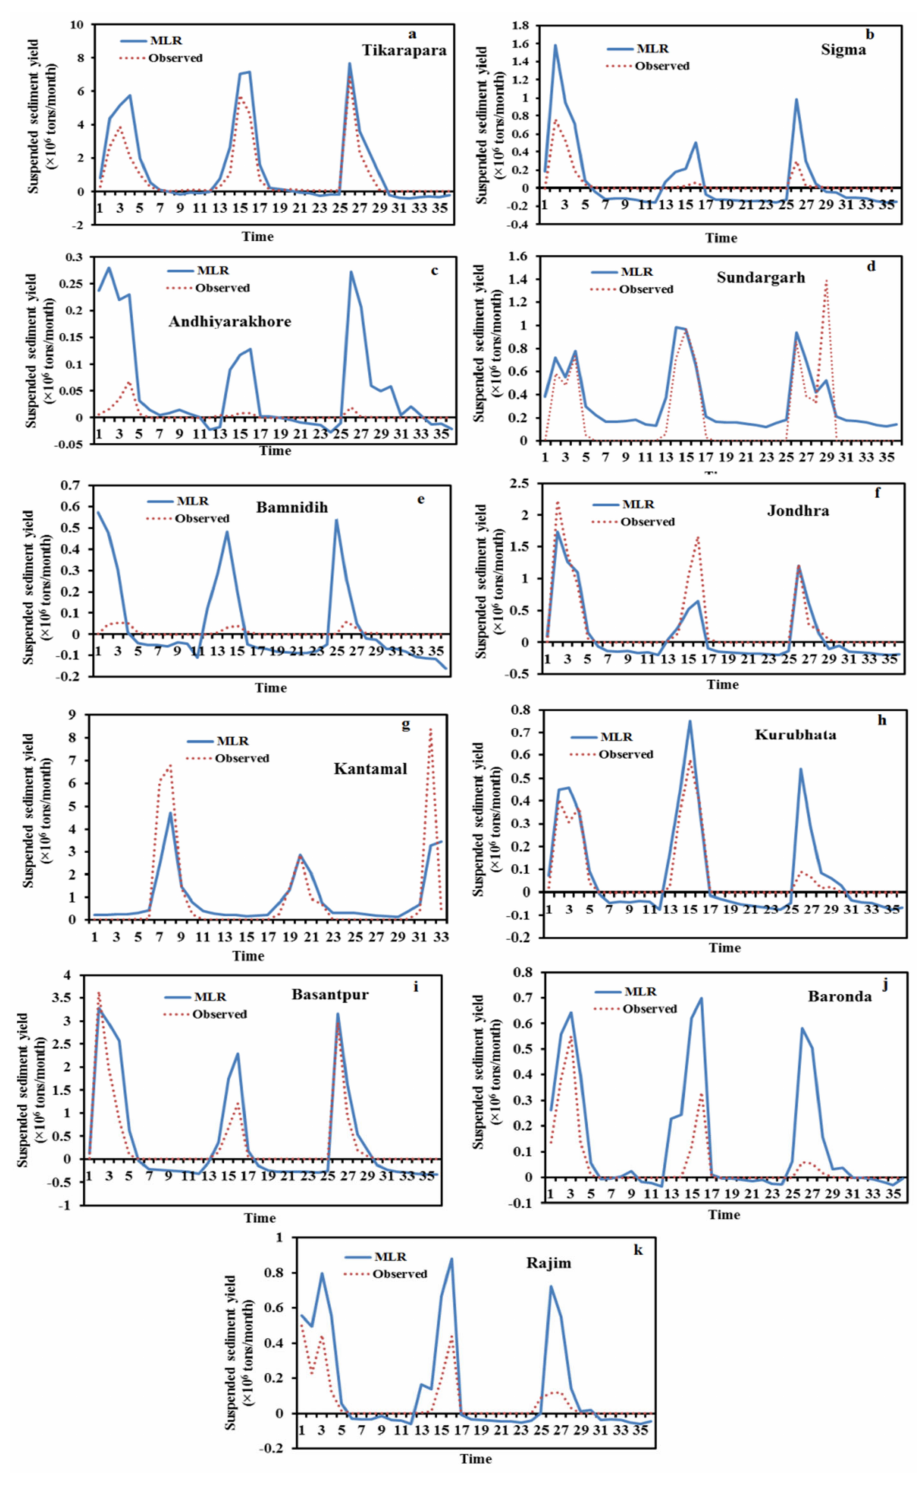
Figure 10. Hydrograph between the predicted and actual SSY of testing data of the MLR